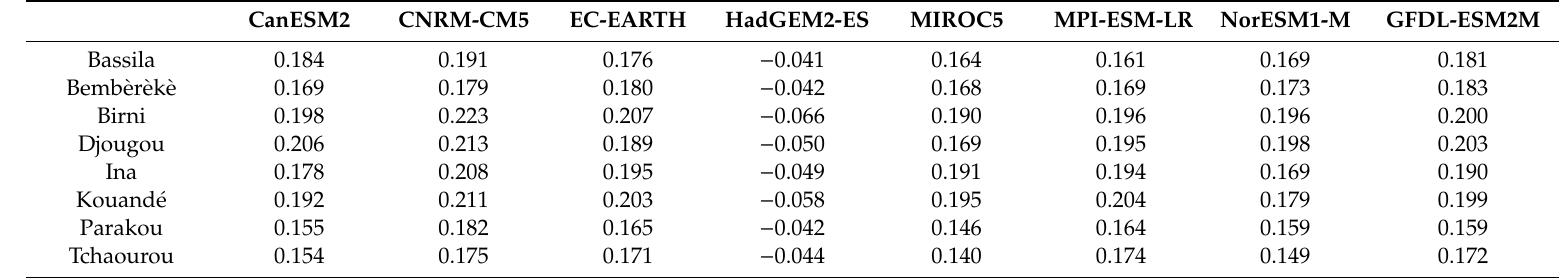
Table 4. Correlation coe ffi cients between observed and simulated precipitation for each station by general circulation model.